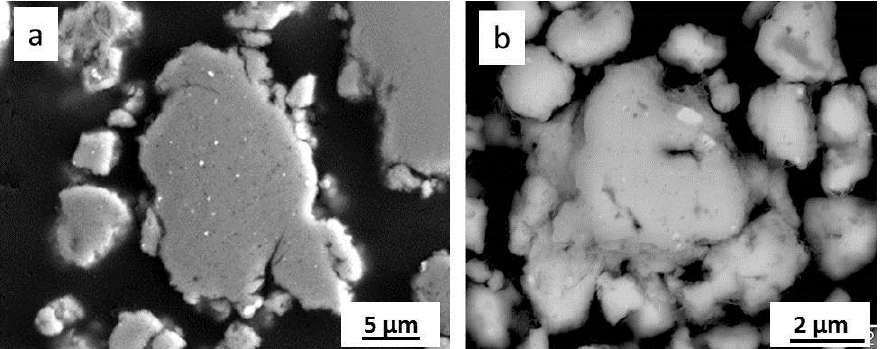
Figure 2. Microstructures of mechanically alloyed powders processed with WC tools after 20 h at 200 rpm: ( a ) V-9Si-13B and ( b ) Mo-9Si-8B. The dark spots are due to remaining Si and B and the white spots are identified as WC particles.